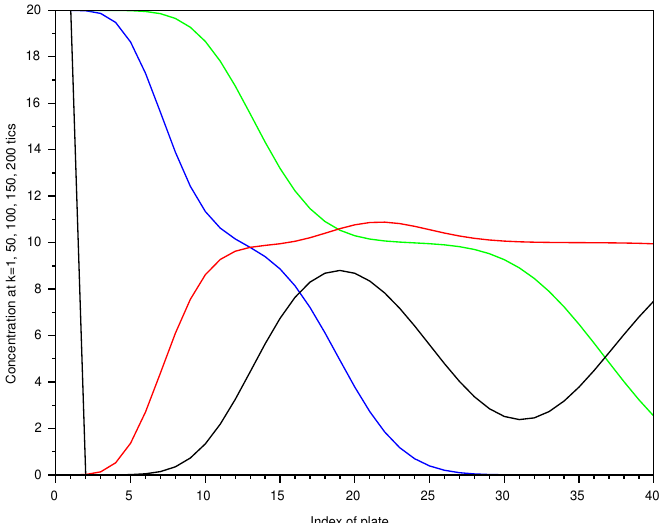
Figure 7. Batch mode: spatial concentration in a column of 40 plates, with a retention ratio (cid:101) m = 0.1, an unit plate volume V c = 1, an amount Q inj = 2.5, from a 100 ticks injection, with two solutes of K d 1 = 0.2 and K d 2 = 0.8. As elution proceeds, the two solutes are not totally separated in the column.The list of instants is color coded: 1 (black), 50 (blue), 100 (green), 150 (red), 200 ticks